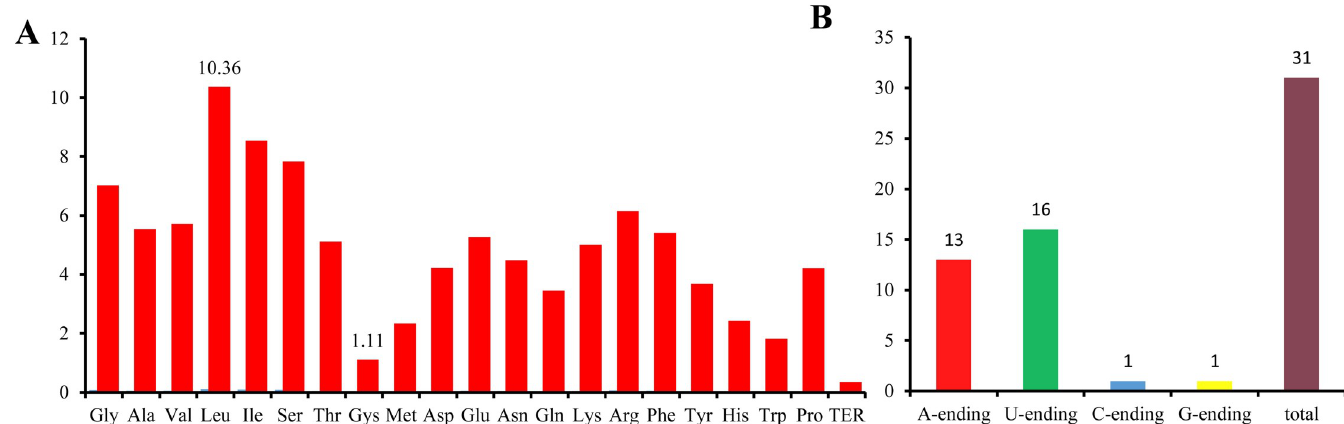
Fig 3. Percentage of amino acids of H . cordata cp genome and the ending patterns of biased usage codons (RSUC > 1). A, Detail information of amino acids used in H . cordata cp genome. B, The A- and U- ending patterns were the most popular in biased usage codons.